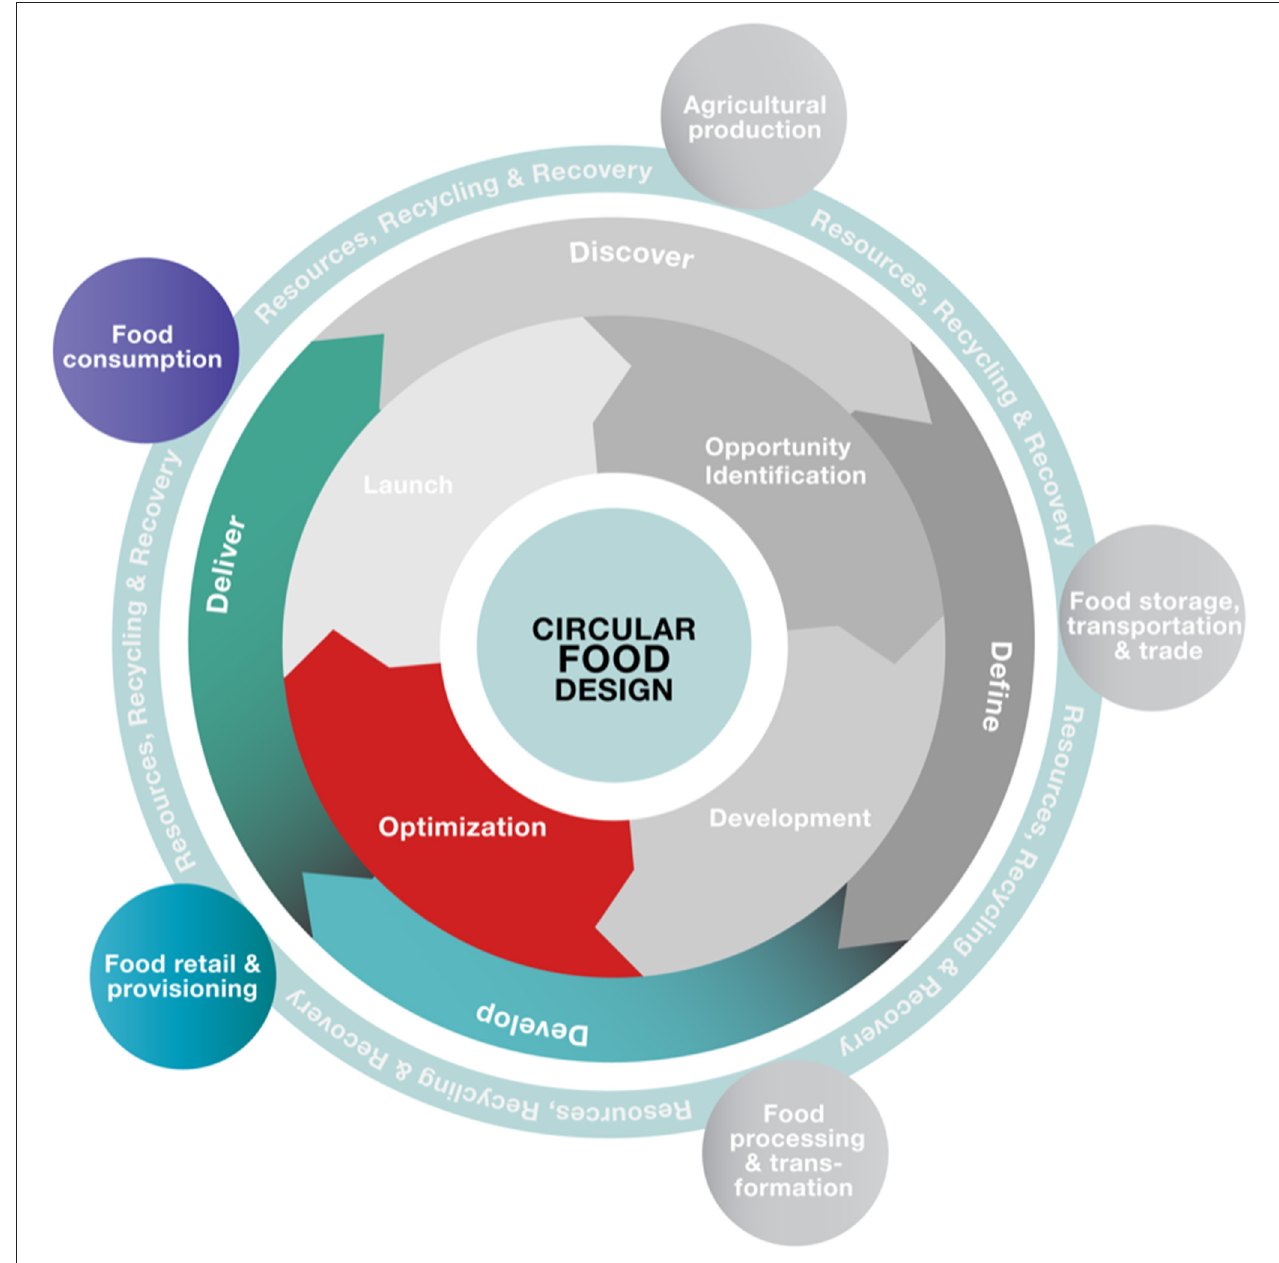
FIGURE 6 | Circular food design, application targeted interventions.